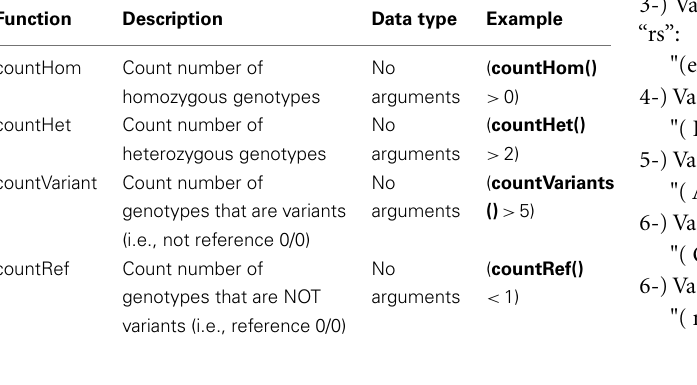
TableA2 | Functions implemented in SnpSift